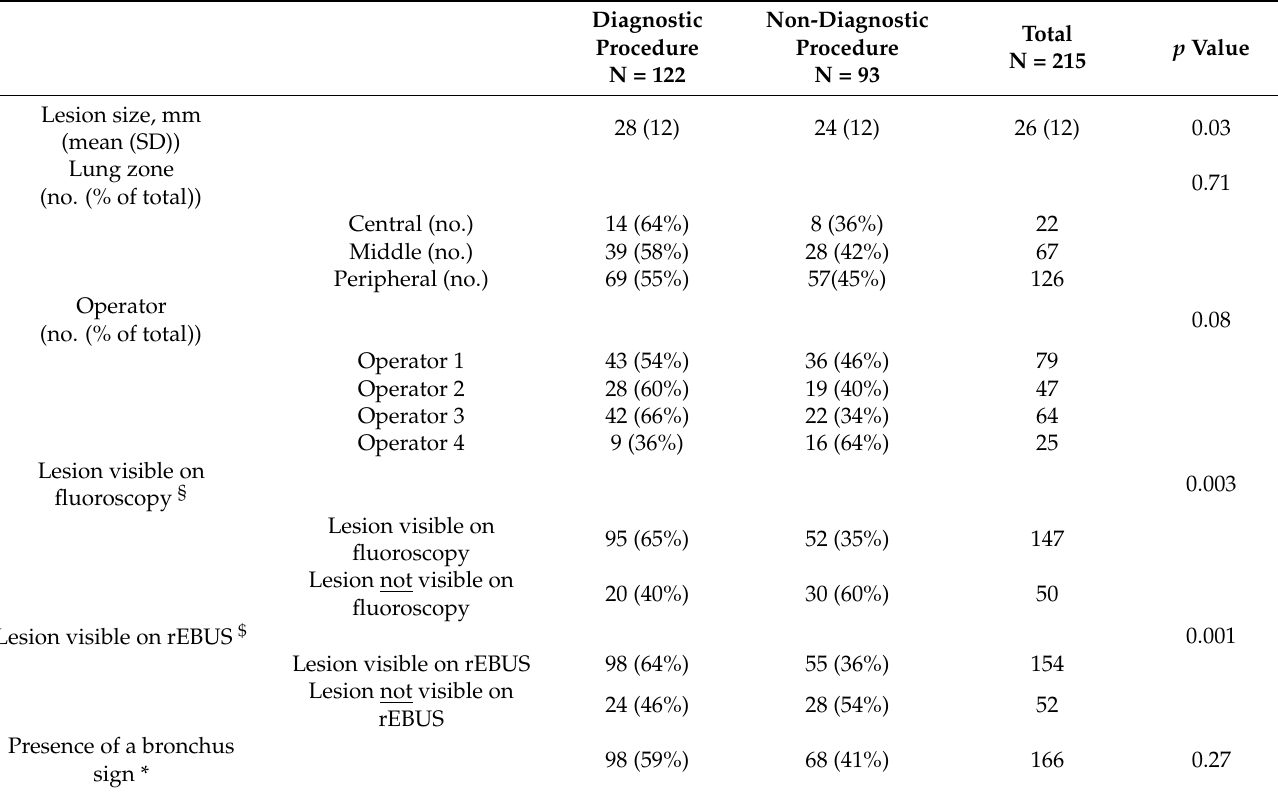
Table 2. Characteristics of diagnostic and non-diagnostic ENB procedures (univariate